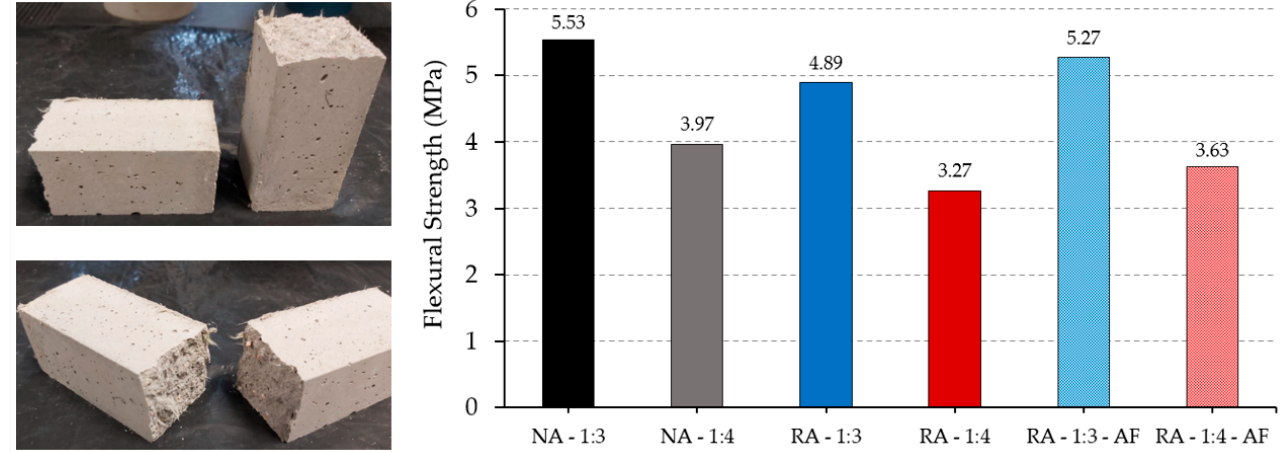
Figure 3. Flexural strength test results and image of specimen RA-1:3-AF type tested.